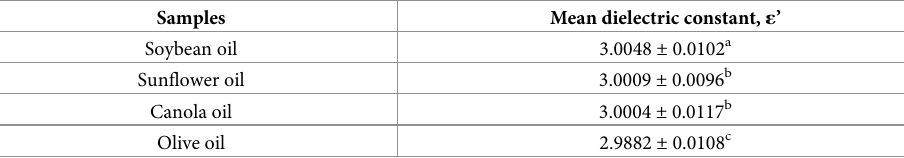
Table 4. Tukey test on the mean dielectric constant of vegetable